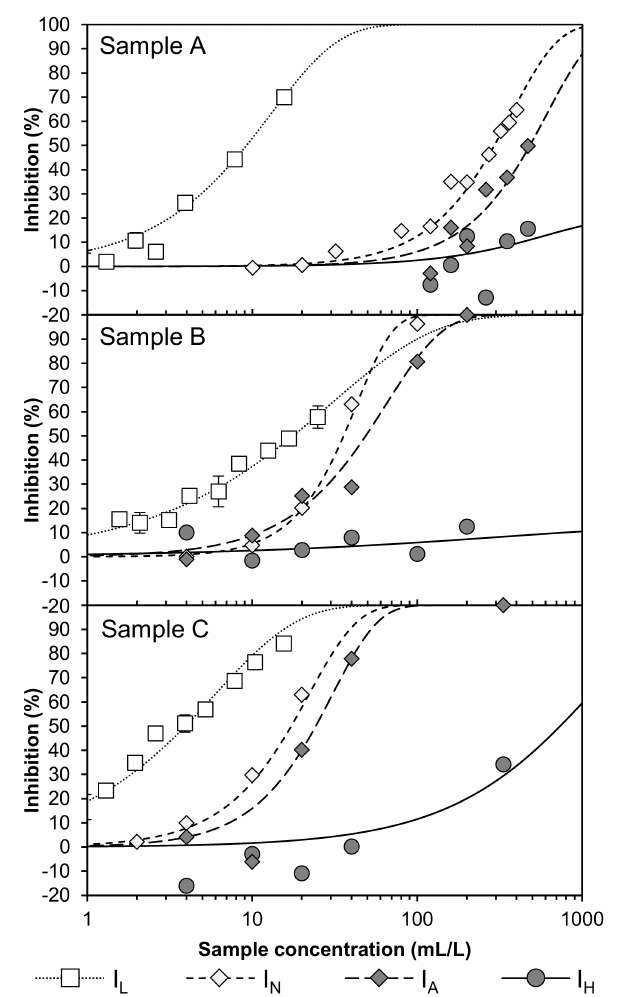
Figure 2. Bacterial inhibition (I) as a function of the sample concentration of three raw wastewater samples from a pesticide processing plant in Vietnam. I L : Luminescent bacteria test; I N : Nitrification inhibition test; I A (autotrophic), I H (heterotrophic): Respiration inhibition test. Sample A: 0.9 g/L COD, sample B: 2.5 g/L COD, sample C: 11.9 g/L